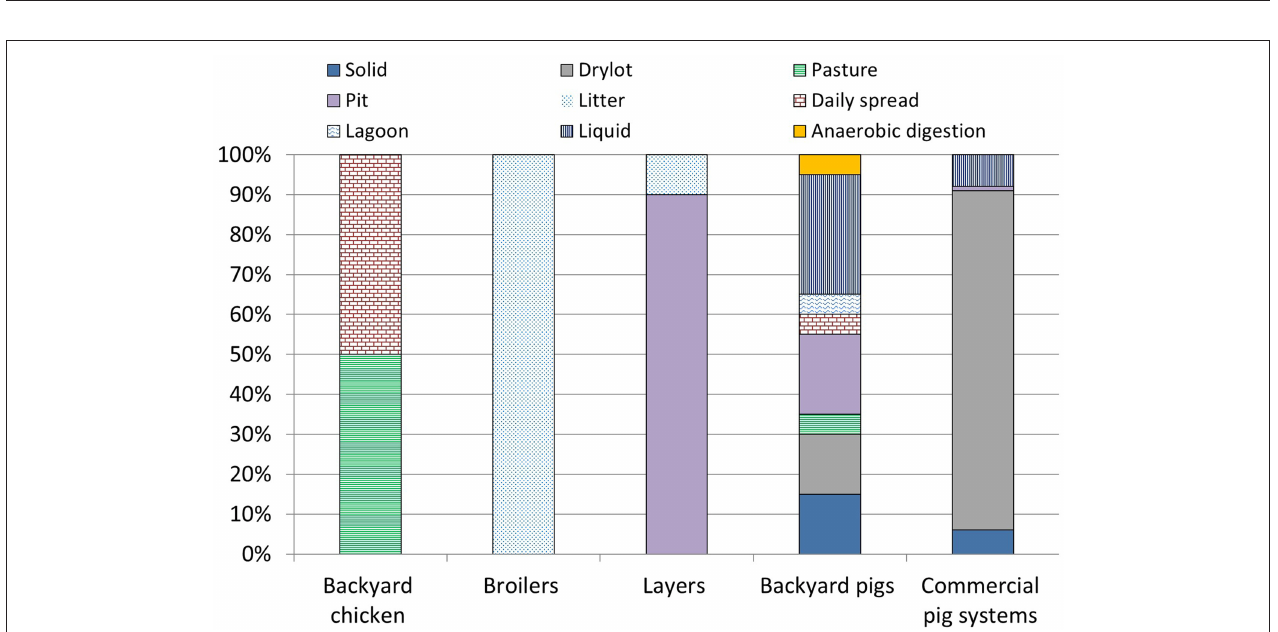
FIGURE 4 | Proportion of poultry and pig producers using various manure management systems in sub-Saharan Africa [Data to create this figure was obtained from MacLeod et al. (2013)].